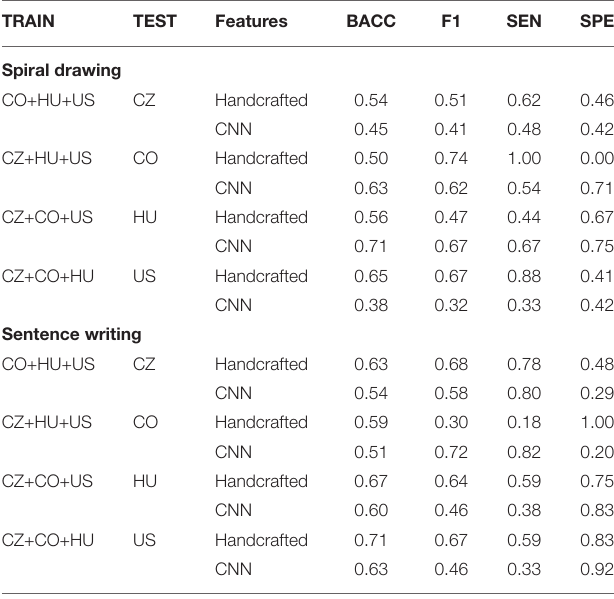
TABLE 5 | Classification performance in the leave-one-language-out